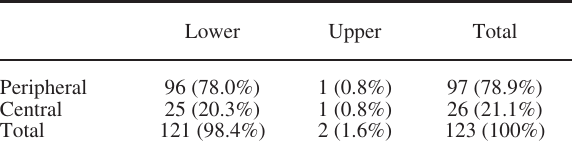
Table 4. – Distribution of interspecific encounters on upper and lower valves, and on central and peripheral zones of the valves.